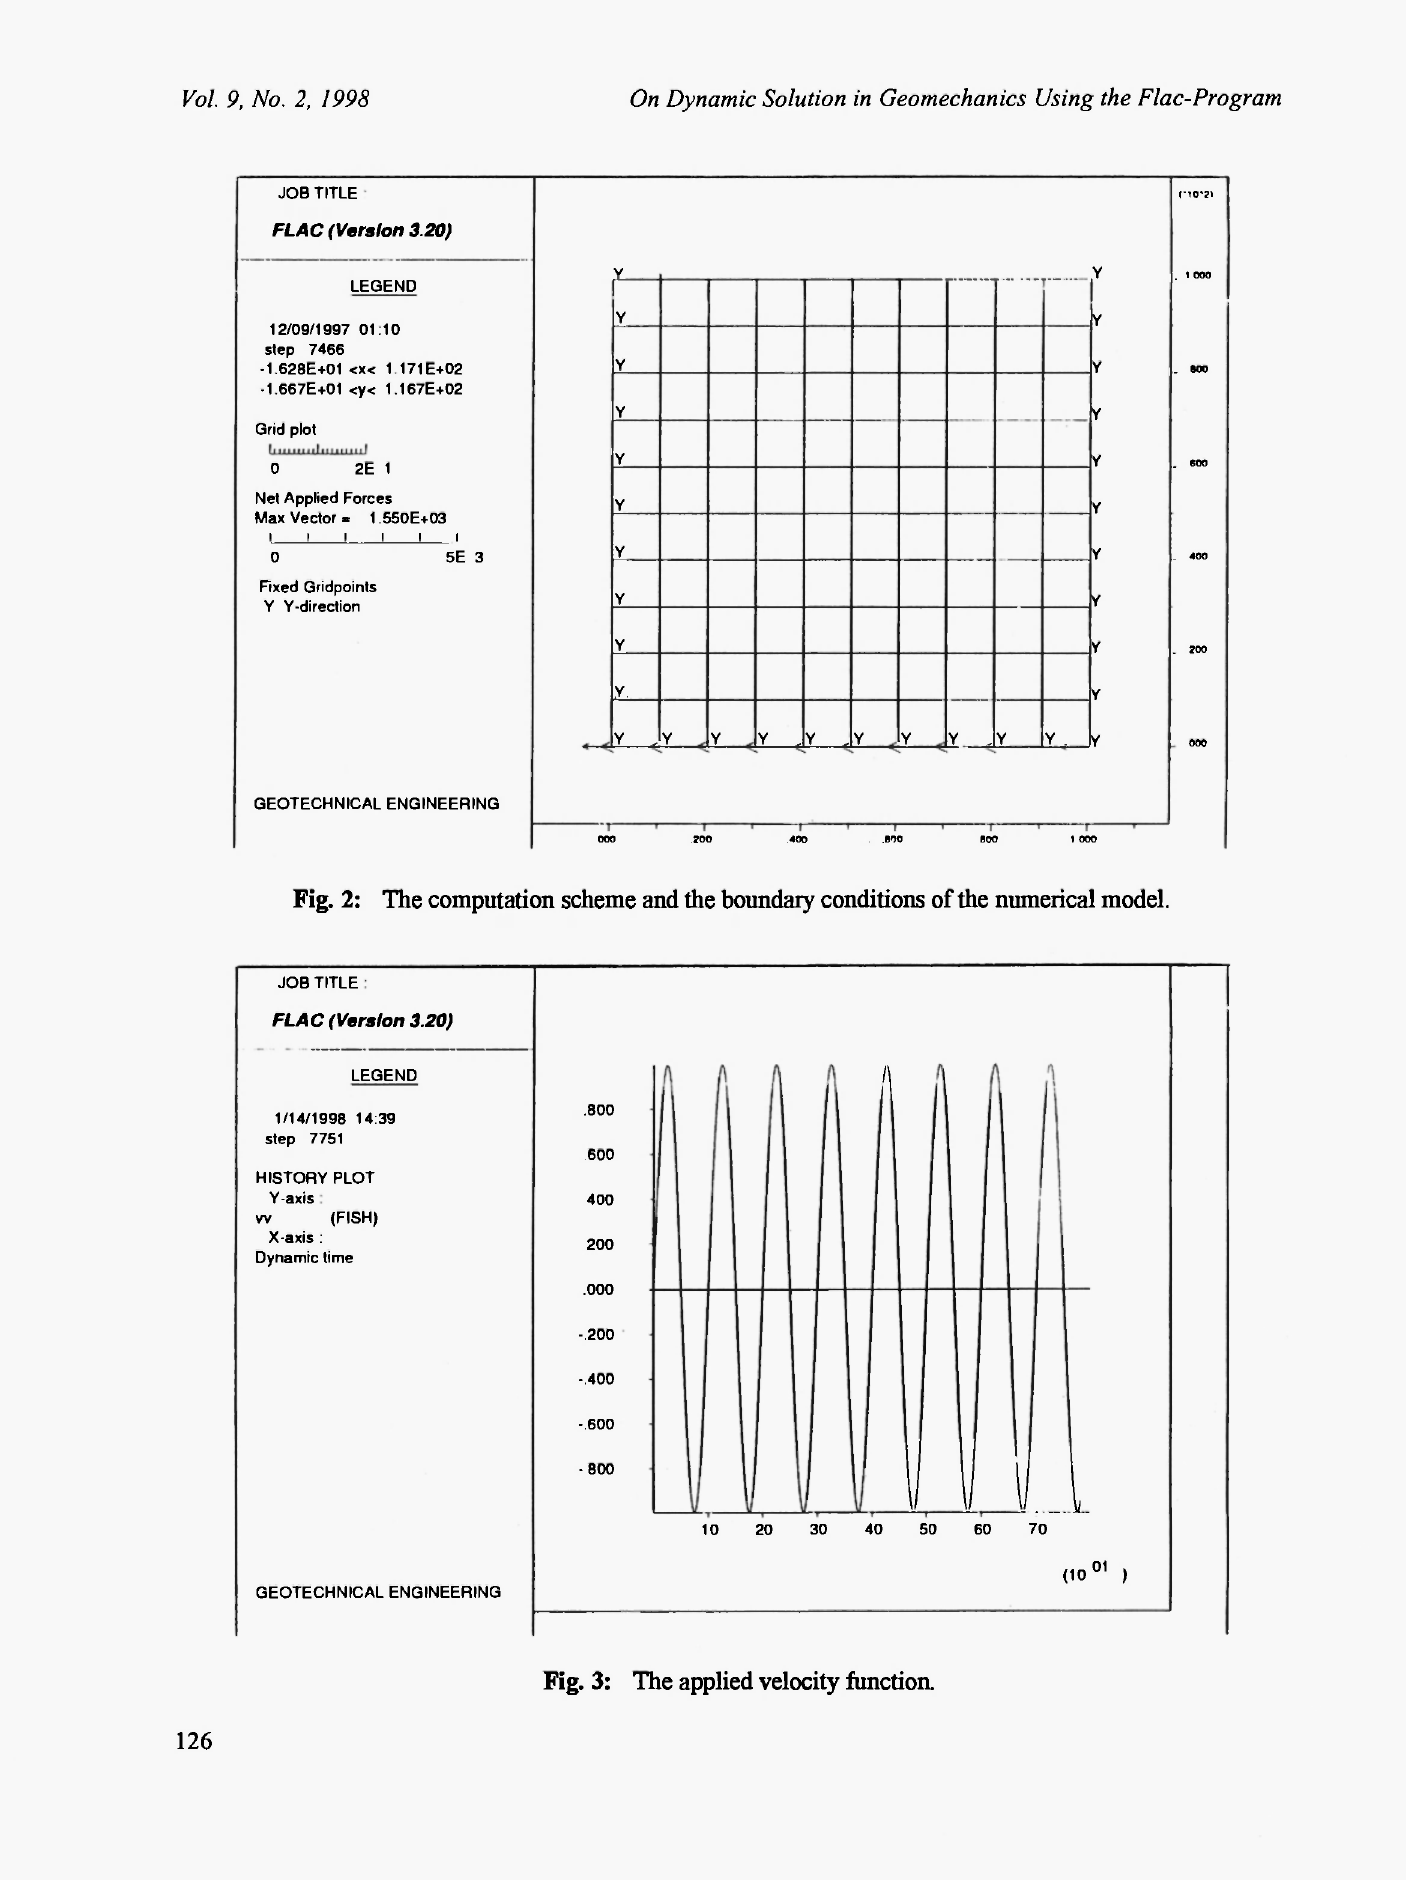
Fig. 2: The computation scheme and the boundary conditions of the numerical model.